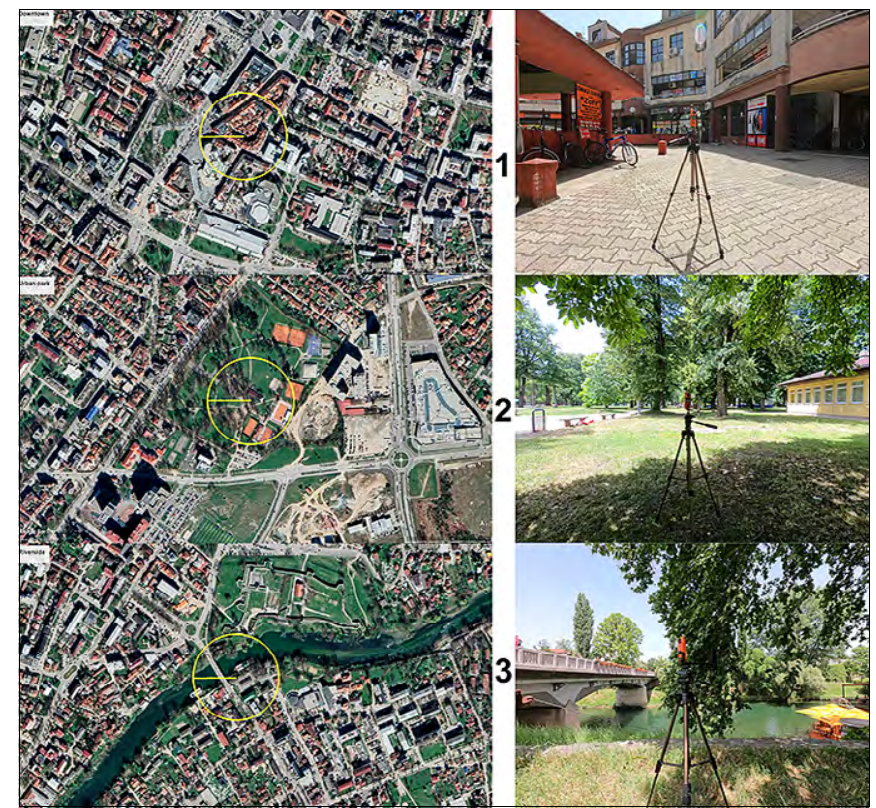
Figure 2. Locations of micrometeorological measurements in Banja Luka (Bosnia and Herzegovina) in the period 22-24 June 2021: 1) Downtown; 2) Urban park; and 3) Riverside